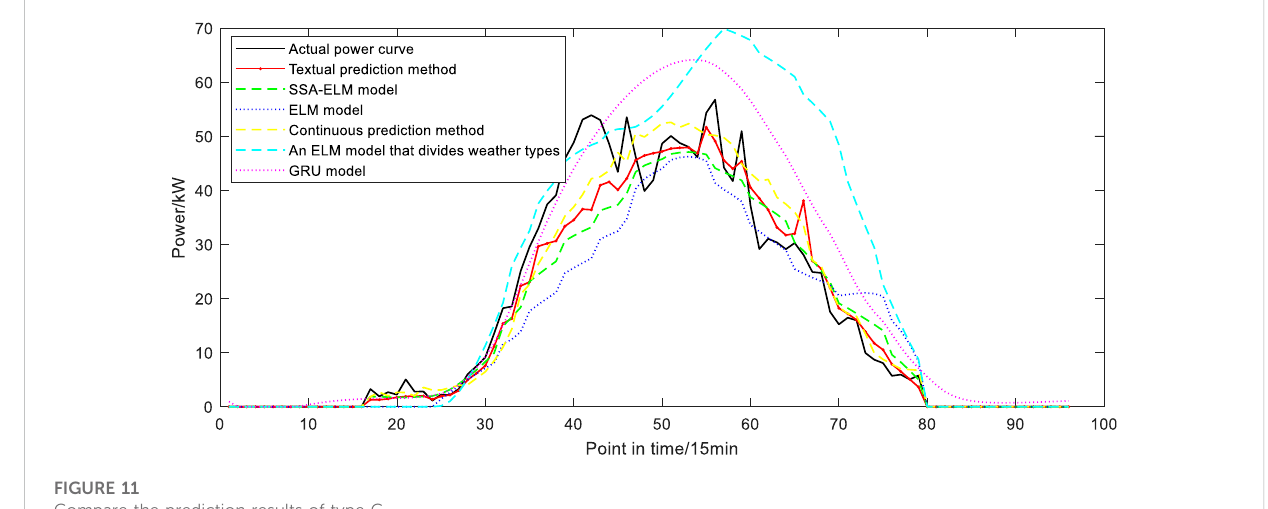
FIGURE 11 Compare the prediction results of type